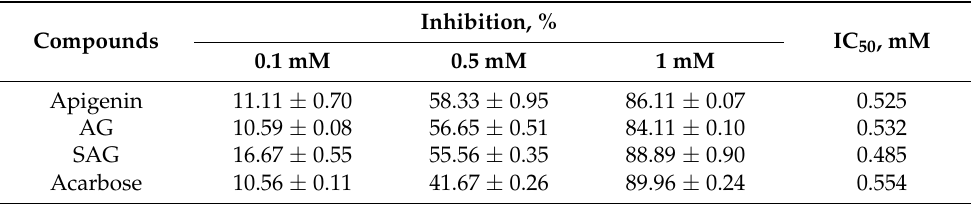
Table 3. α -Glucosidase inhibitory activity analysis of active compounds.